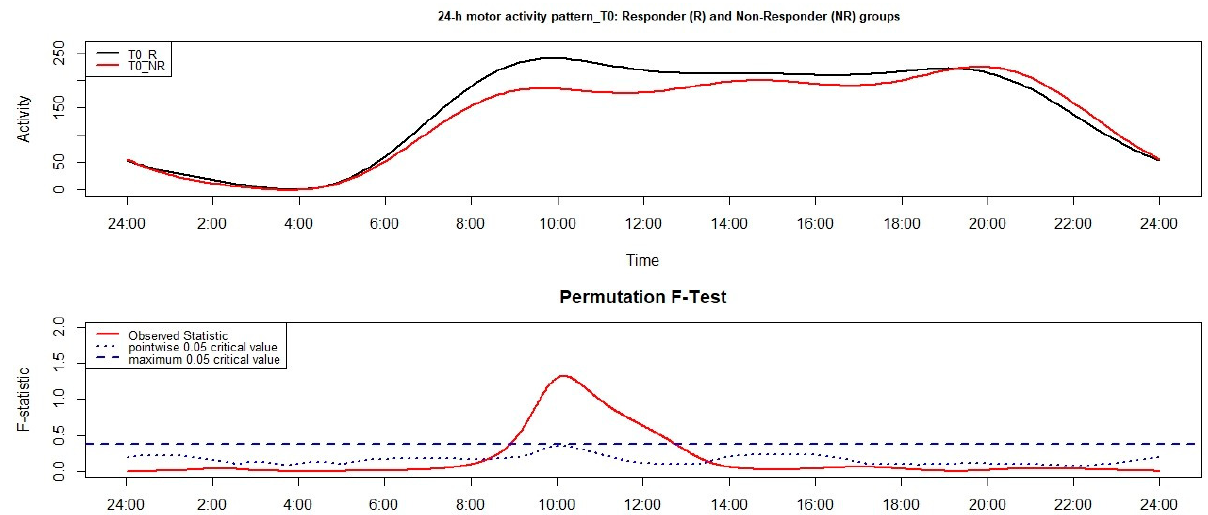
Figure 1. Results of the functional linear modeling applied to the group comparison between responder (R) and non- responder (NR) groups at T0. The functional forms of the 24-h motor activity patterns of groups are reported in the upper panel while the results of the non-parametric permutation F-test in the lower panel. Significant results are observed when the solid red line is above the blue dashed line. Table 2. Means and standard deviations of actigraphic sleep/wake parameters, measured at T1, in the non-responder (NR) group and responder (R)